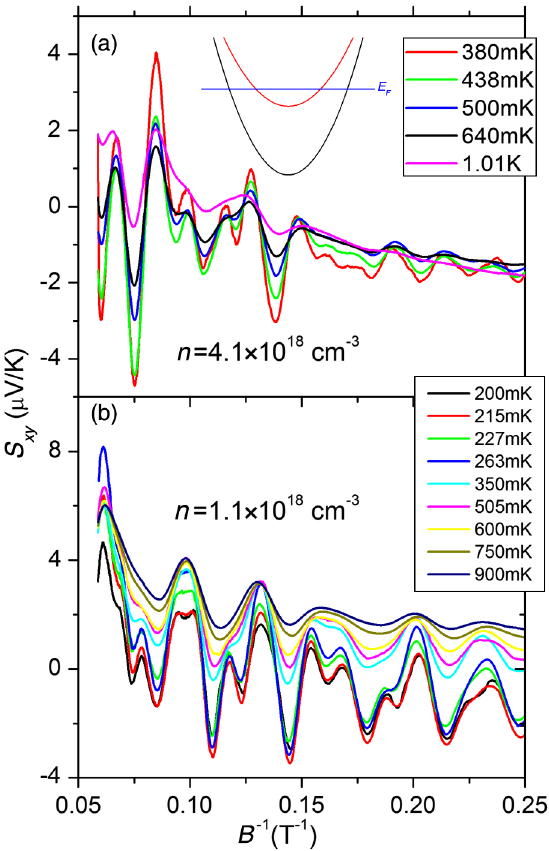
FIG. 2. Nernst signal as a function of the inverse of the magnetic field for two carrier concentrations. The quantum oscillations display a complex structure with multiple periodici- ties. The inset shows a sketch of the position of Fermi energy relative to the two lowest bands at the (cid:1)